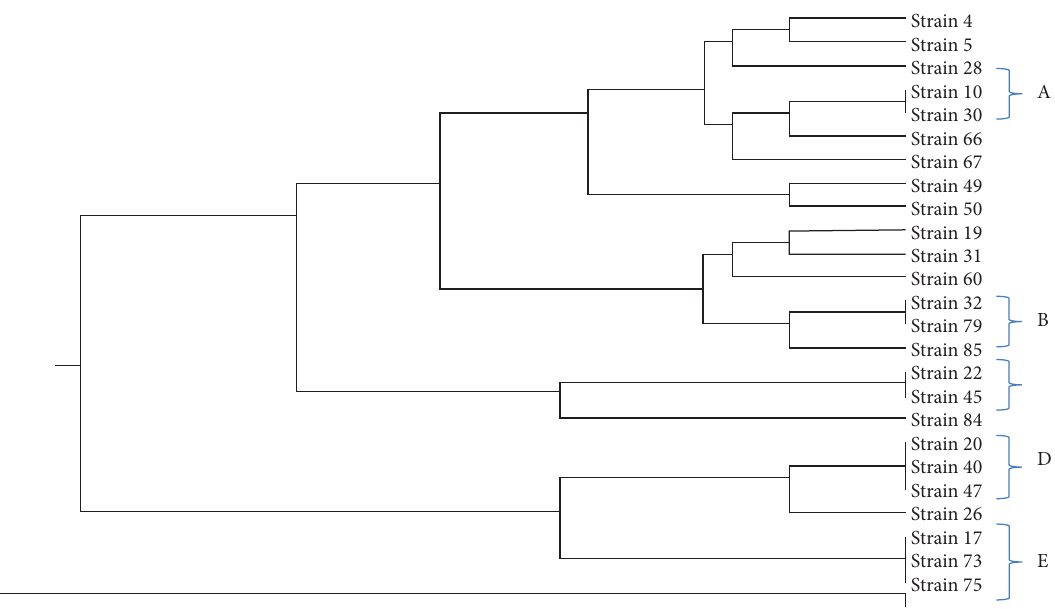
Figure 3: Dendrogram of ERIC-PCR types of qnr-positive K. pneumoniae strains, compared by dice method and grouped by UPGMA